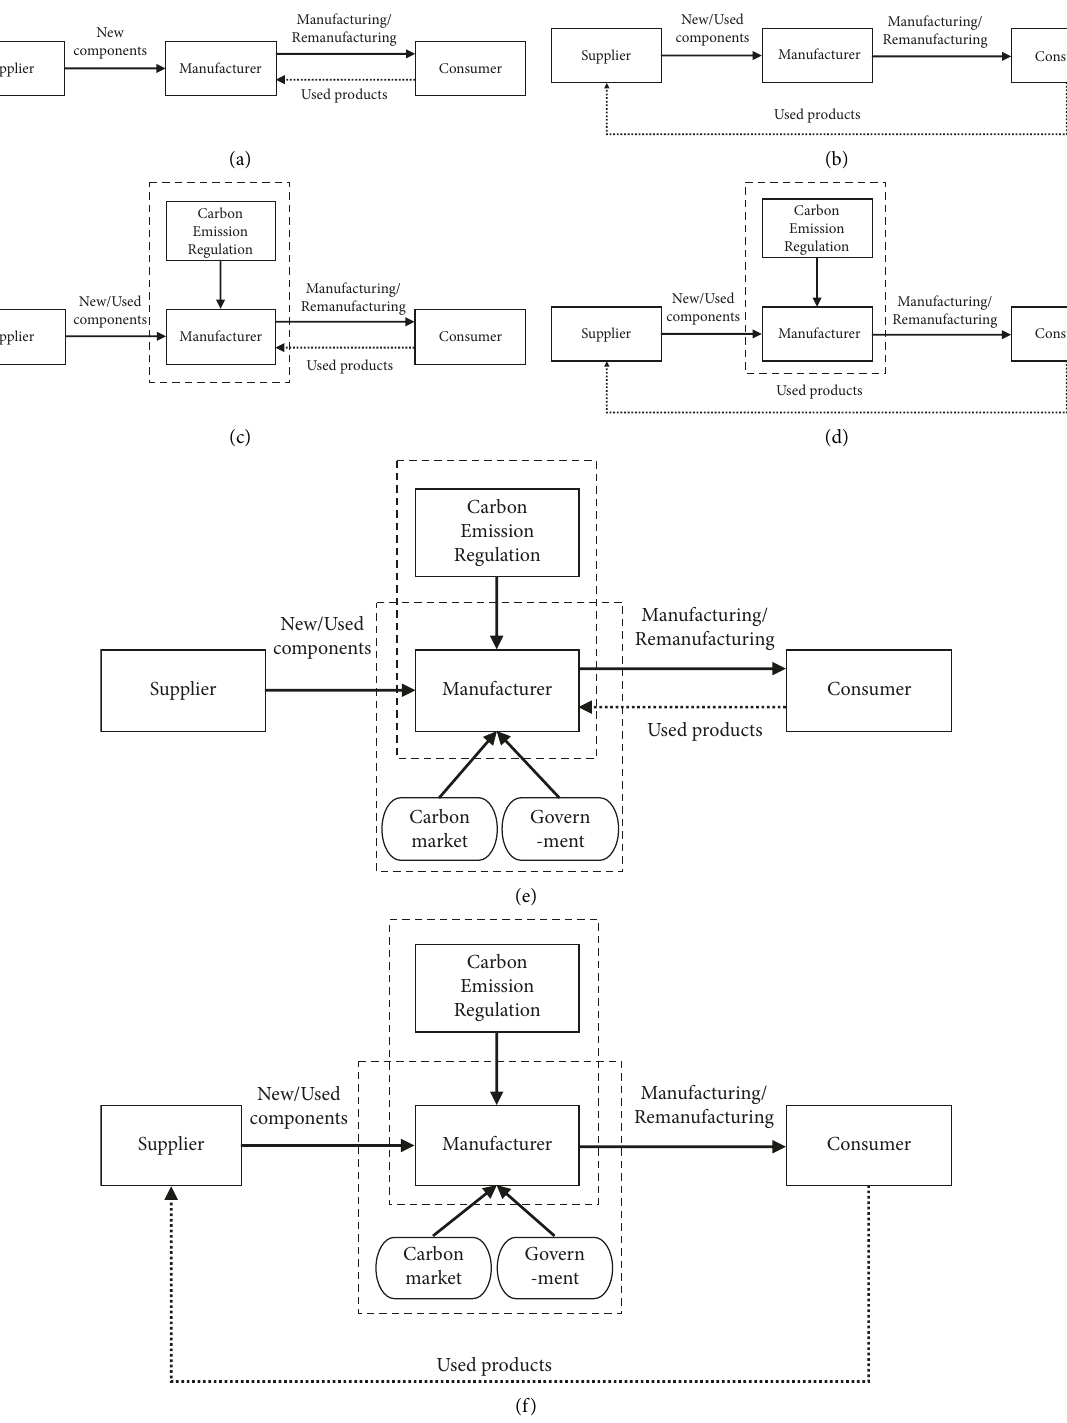
Figure 1: The CLSC structures. (a) Model M. (b) Model S. (c) Model ME. (d) Model SE. (e) Model MC. (f) Model